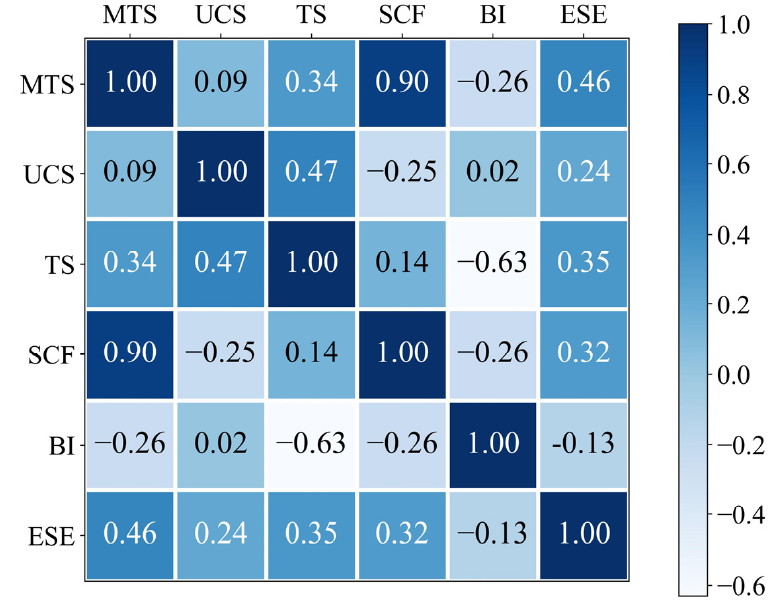
Figure 5. Histogram distribution of the database.